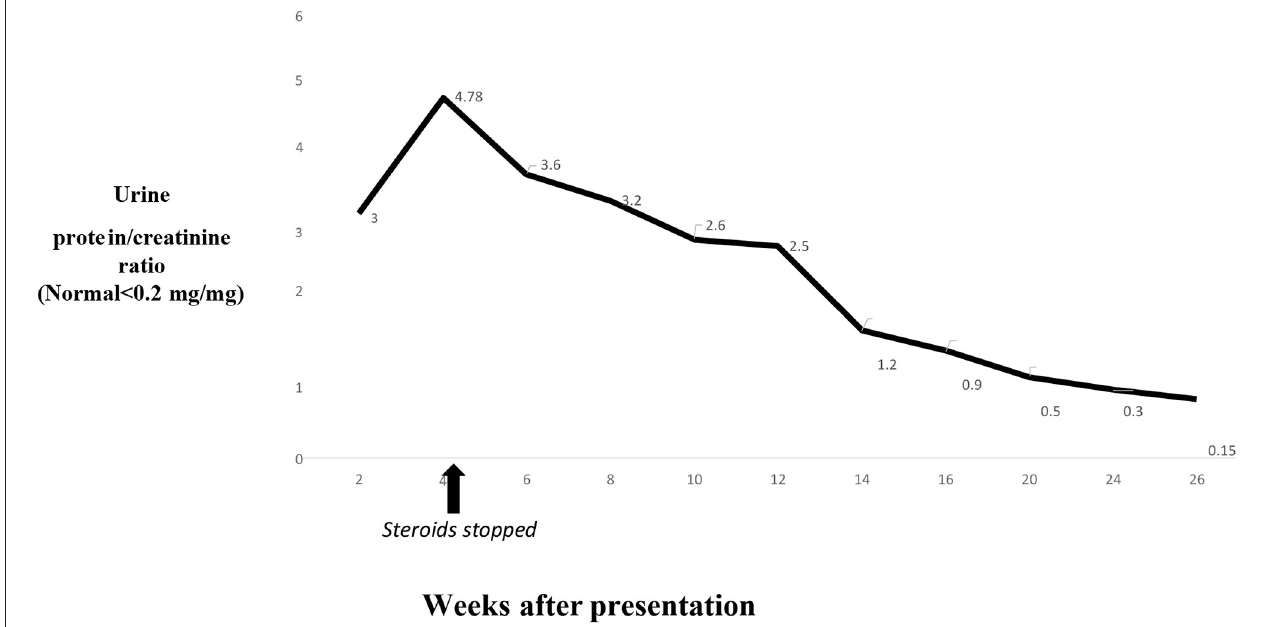
FIGURE 6 | Trends in proteinuria on ACE inhibitor